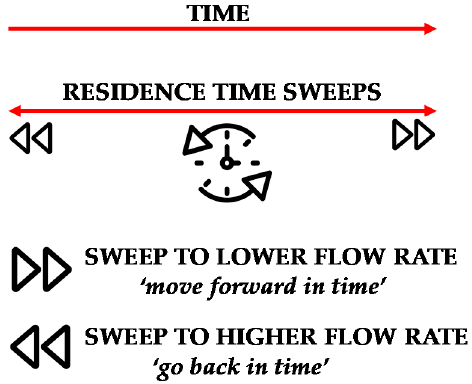
Figure 2. Time sweep experiments in a microreactor/mass spectrometry setup.